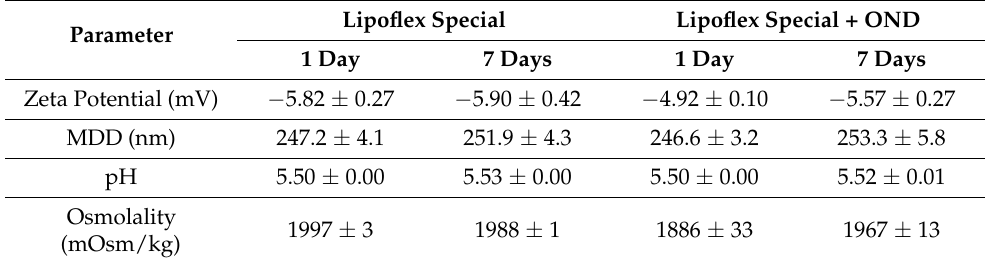
Table 1. Physicochemical characteristic of Lipoflex special with and without ondansetron (OND). Lipoflex Special Lipoflex Special + OND Parameter